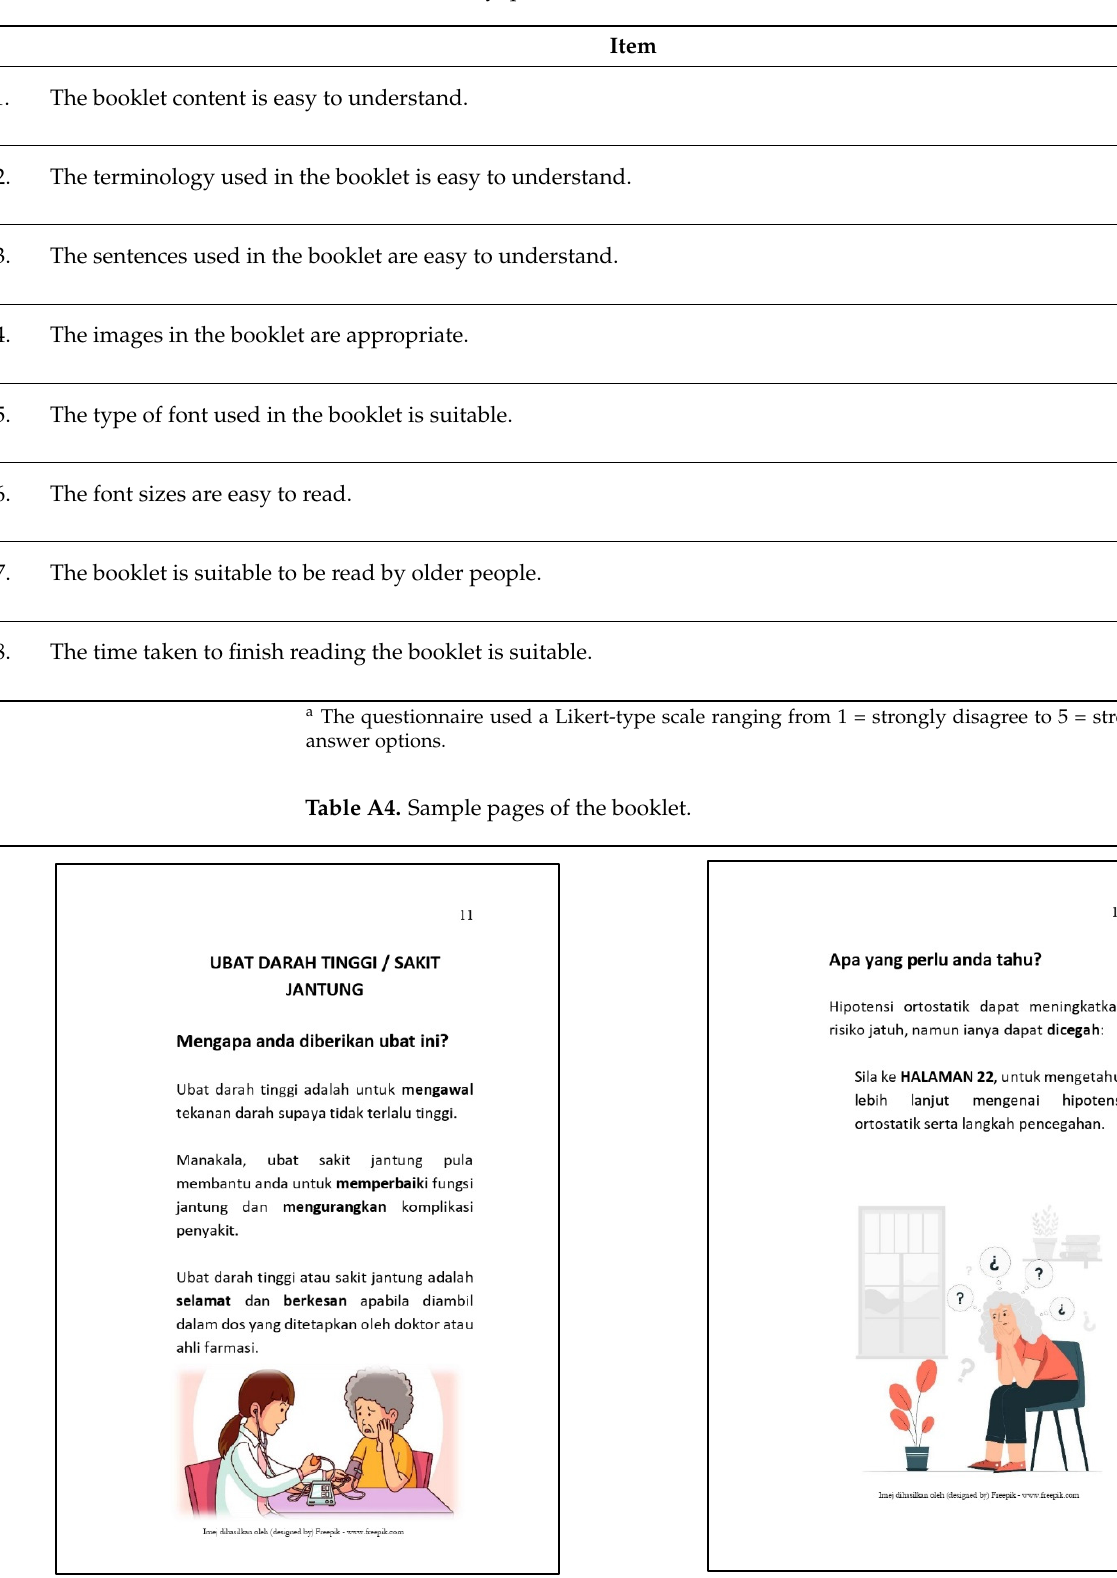
Table A3. Usability questionnaire a .